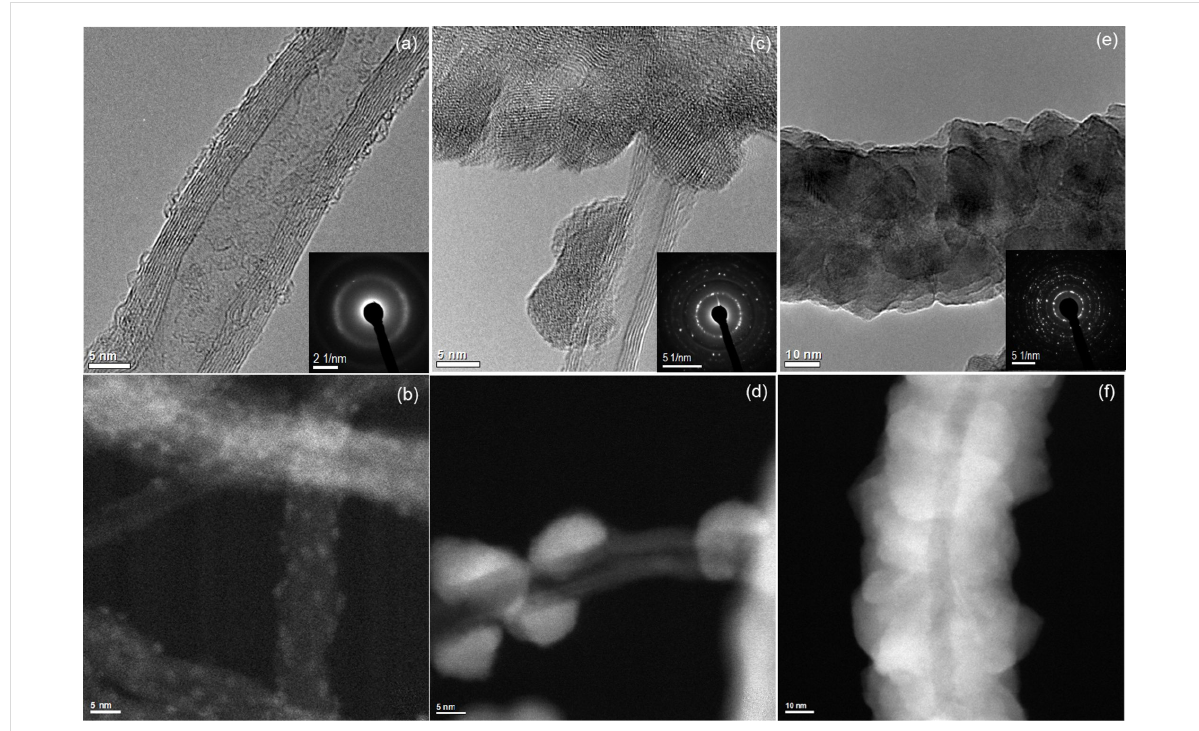
Figure 3: Micrographs of TiO 2 deposited on MW-CNT by using ALD with different number of cycles to control the particle size. (a), (c) and (e) are the high-resolution TEM images after 20, 200 and 750 cycles, respectively. The inset shows selected area diffraction pattern (SADP). (b), (d) and (f) are the respective STEM-HAADF images providing a higher contrast between the TiO 2 particles and the